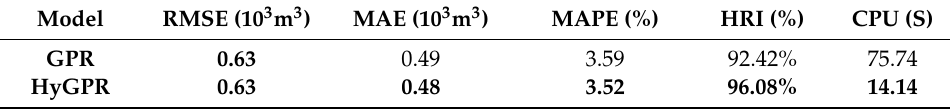
Table 4. Accuracy and interval metrics of GPR and HyGPR (The best metrics are highlighted in bold). Model